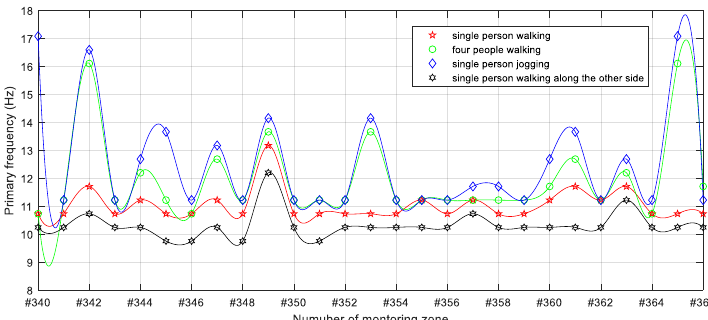
Figure 11. Fitting distribution of effective values of vibration response of incursion range under different simulated intrusion cases.